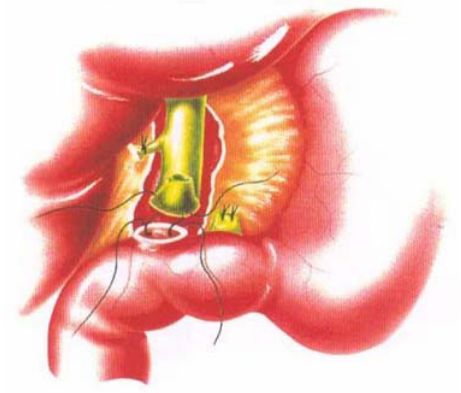
FIGURA 9 - Fotografia da operação que mostra o aspecto operatório da eversão da parede coledociana, com o ponto de fixação na parede posterior do colédoco (seta 1 ) e coto distal do colédoco fechado (seta 2). A sonda na luz coledociana foi para melhor efeito fotográfico.